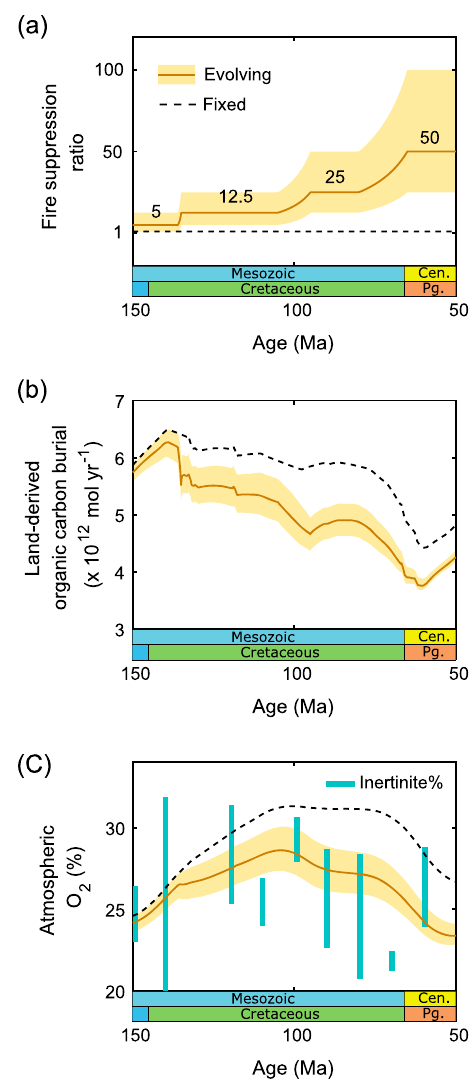
Fig. 3 Model run from 150 to 50 Ma with changing fi re feedbacks. a Dark orange line with yellow shaded area shows an evolving ‘ fi re suppression ratio ’ , representative of the changing fuel source due to angiosperm evolution. The yellow shaded area indicates how uncertain the evolutionary changes in the fi re regime are and how this is propagated to the model results. The size of the uncertainty window represents the suppression ratio of the previous and next evolutionary stages. Black dashed line shows fi xed weak fi re feedback in the baseline COPSE model. b Modelled land-derived organic carbon burial. C Modelled atmospheric oxygen mixing ratio compared to inertinite-derived estimates from ref. 47 as blue